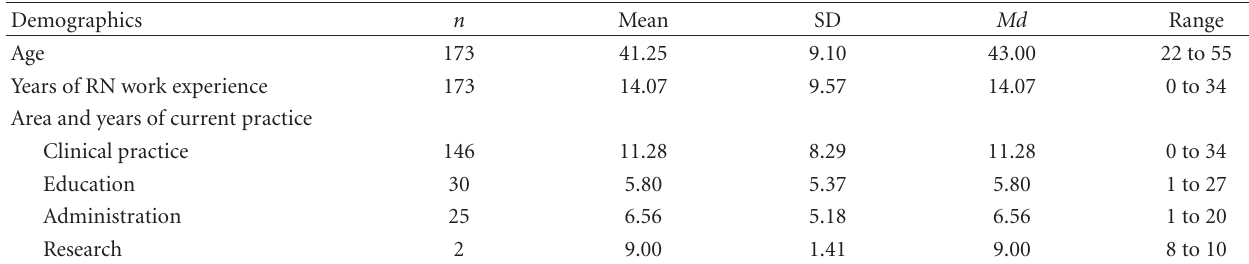
Table 2: Descriptive statistics of continuous demographic